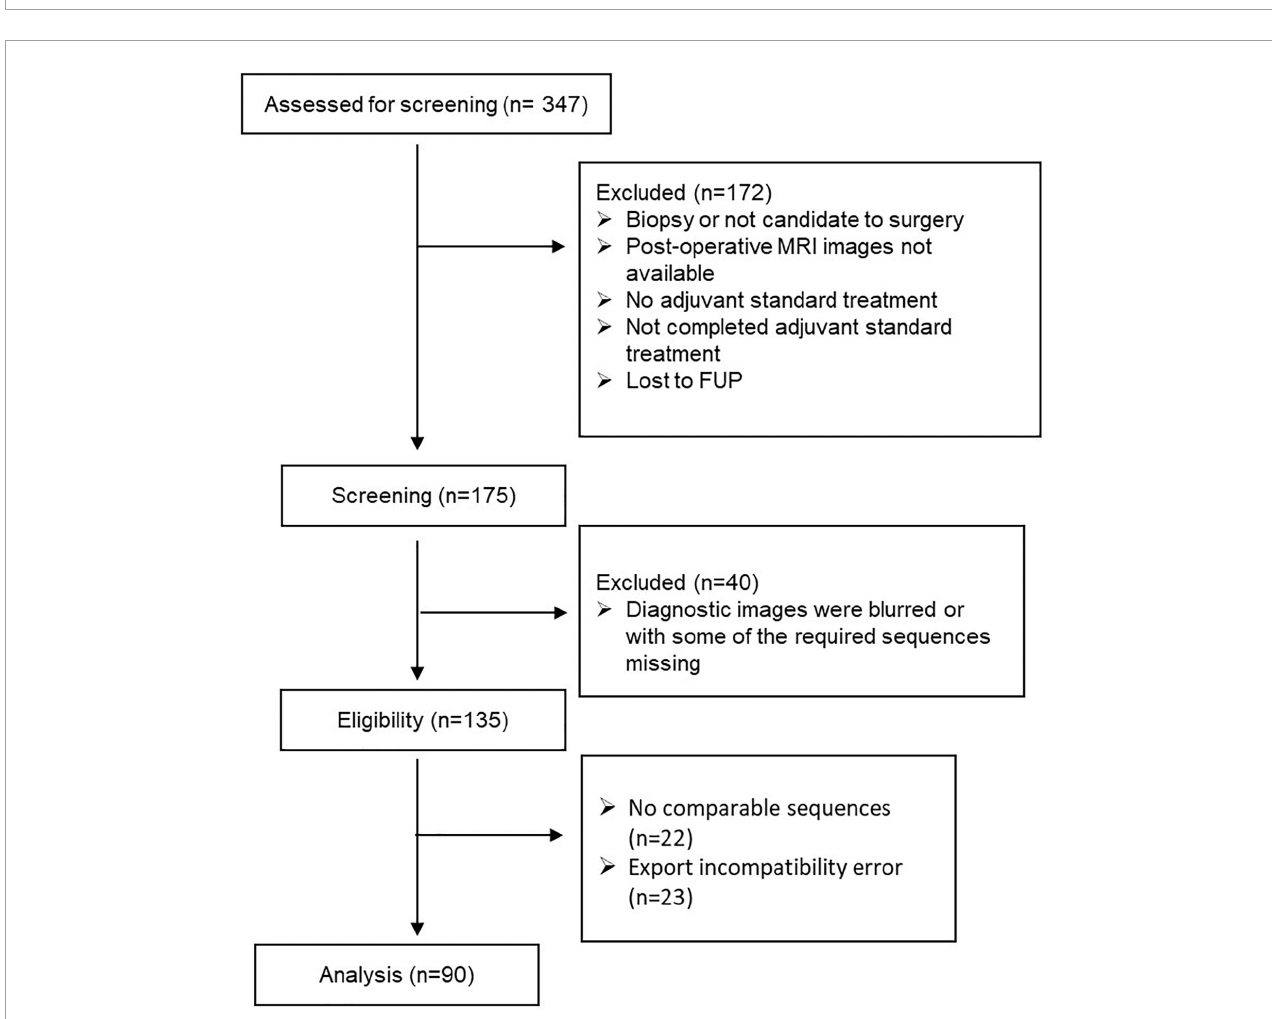
FIGURE2 Patients’